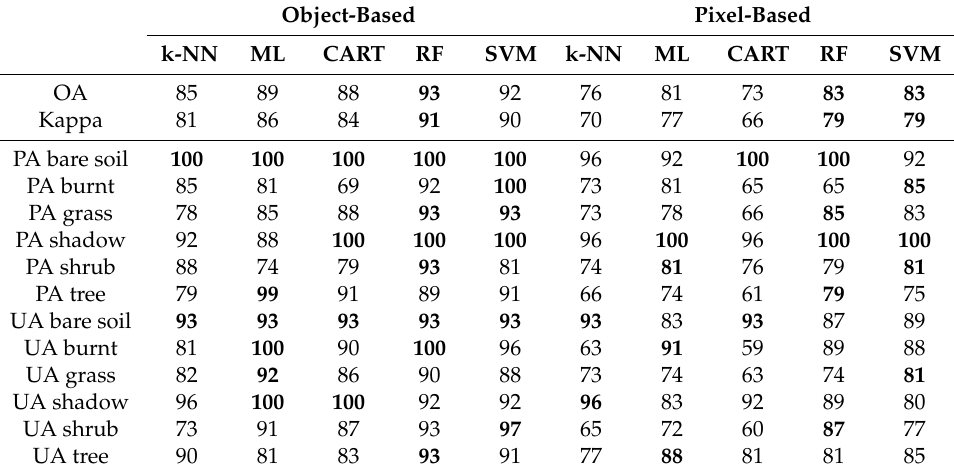
Table 8. Accuracy indices (%) for all five pixel- and object-based classifiers for March 2013. Bold values represent the maximum value. OA = Overall Accuracy; PA = Producer Accuracy; UA = User Accuracy.